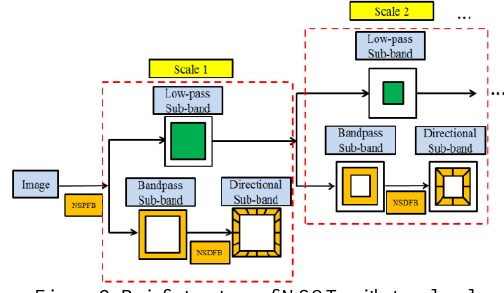
Figure 2. Brief structure of NSCT with two